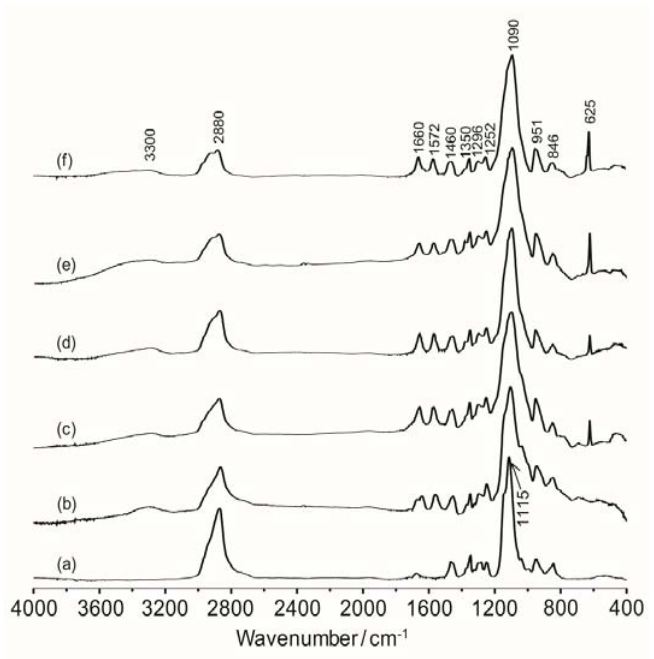
Figure 2. FTIR spectra of ( a ) pure ED2000 and TIE(2000)-Z hybrid electrolytes with Z = ( b ) ∞ ; ( c ) 32; ( d ) 24; ( e ) 16 and ( f )